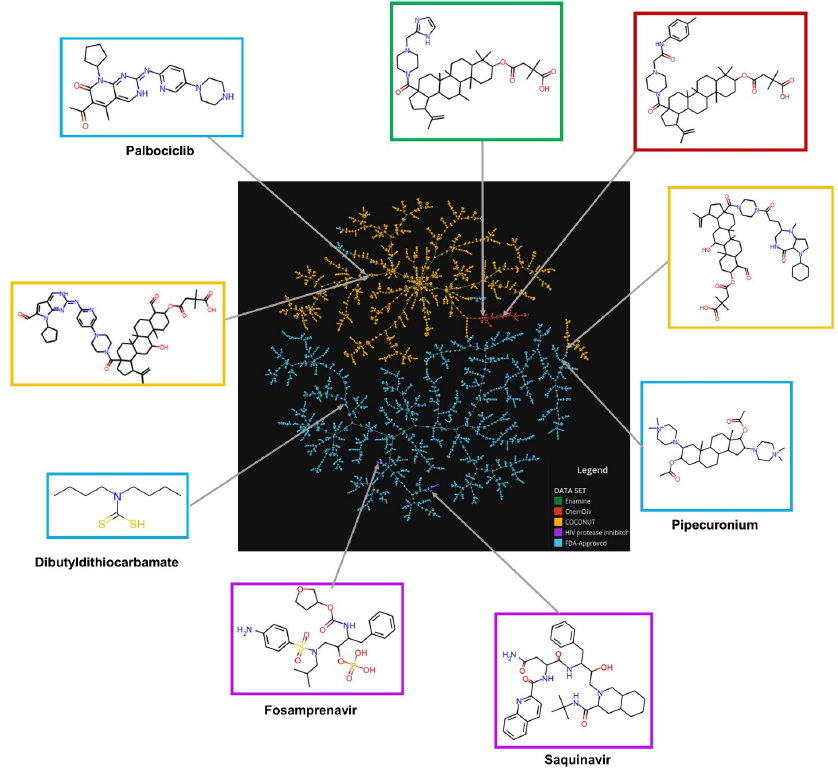
Figure 7. Chemical space visualization of the virtual focused compound library of HIV-1 viral protease inhibitors from natural product fragments and two compound reference libraries using TMAP based on molecular fingerprints. Compounds reference libraries represented in colors: FDA-approved drugs (blue), and FDA-approved HIV-1 protease inhibitors (purple). Likewise, for new chemical compounds generated from COCONUT (orange), ChemDiv (red), and Enamine (green) fragment libraries. The interactive version is available at https://figshare.com/s/ceb58d58e8f5585ce67e (accessed on 5 November 2021).